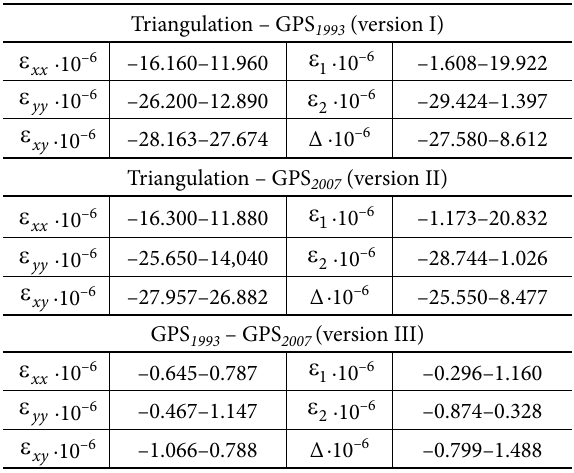
Table 2. Characteristics of the Earth’s crust horizontal